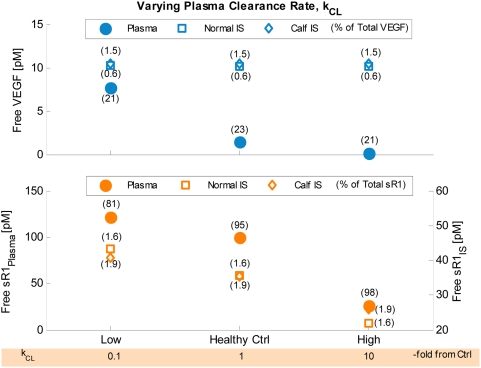
Steady-state Effects of Plasma Clearance Rate (kCL) on VEGF and sVEGFR1 Concentrations.Increasing kCL resulted in: (i) drastically lower plasma concentrations of both free VEGF and sVEGFR1, (ii) lower interstitial sVEGFR1 but unchanged interstitial VEGF, and (iii) reduced transendothelial gradient for VEGF but not for sVEGFR1.